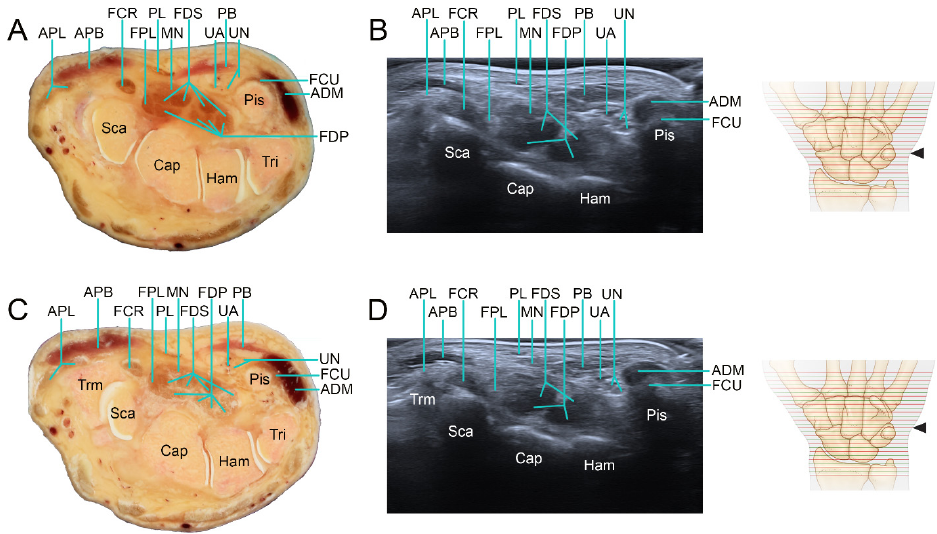
Figure 5. Sectioned images ( A , C ) and corresponding US ( B , D ) images for transverse views at the distal part of the proximal carpal bones. ( A , B ) The Sca becomes smaller and the Cap becomes larger. The PL tendon becomes flat and is between the abductor pollicis brevis (APB) and palmaris brevis (PB). The FCR tendon is deep to the APB. The ADM becomes thicker and is on the ulnar side of the Pis and FCU tendon. In the thenar eminence, the APB muscle and abductor pollicis longus (APL) tendon are observed. The FPL tendon is oval in shape and is just radial to the FDS and FDP tendons. The MN is on the second and third FDS tendons and is deep to the PL tendon. The UN and UA are just radial to the Pis, and are anterior to the fourth and fifth FDS tendons and deep to the PB. ( C , D ) At a more-distal level, the Pis and trapezium (Trm) become smaller. The Trm appears to articulate with the Sca. The ADM becomes thicker, and the FCR tendon is just on the ulnar side of the Trm. The MN is on the second and third FDS tendons deep to the PL tendon. The UN and UA are radial to the Pis, on the fourth and fifth FDS tendons, and deep to the PB. Arrowheads in the schematics indicate the levels of the wrist scanned by the US transducer.